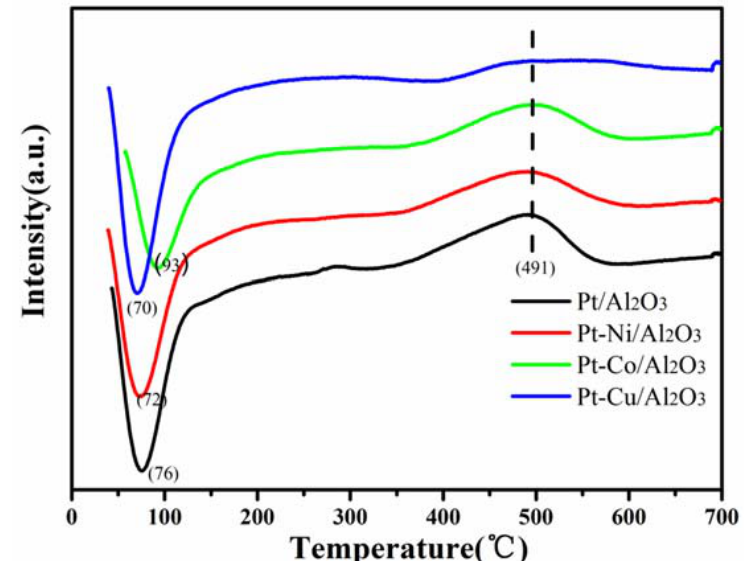
Figure 3. H 2 ‐ TPR profiles of as ‐ synthesized Pt/Al 2 O 3 and Pt ‐ M/Al 2 O 3 samples. Figure 3. H 2 -TPR profiles of as-synthesized Pt/Al 2 O 3 and Pt-M/Al 2 O 3